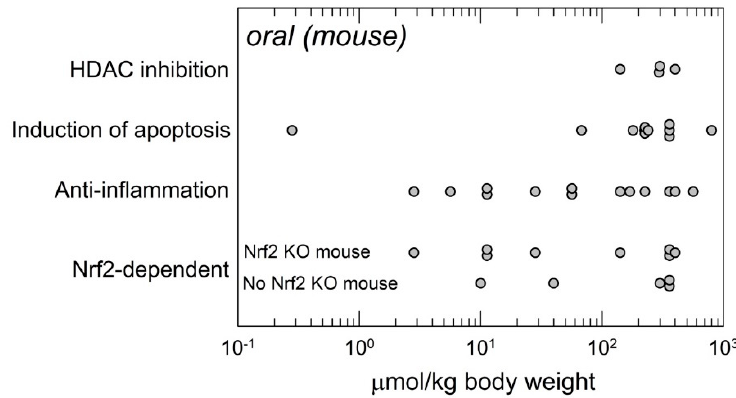
Figure 3. Distribution of oral doses of sulforaphane administered to mice in studies that included experimental examination of underlying mechanisms in vivo. Data are as reported and interpreted in the original publications. Listed mechanisms are not necessarily exclusive. Nrf2 KO: Nrf2 knockout.